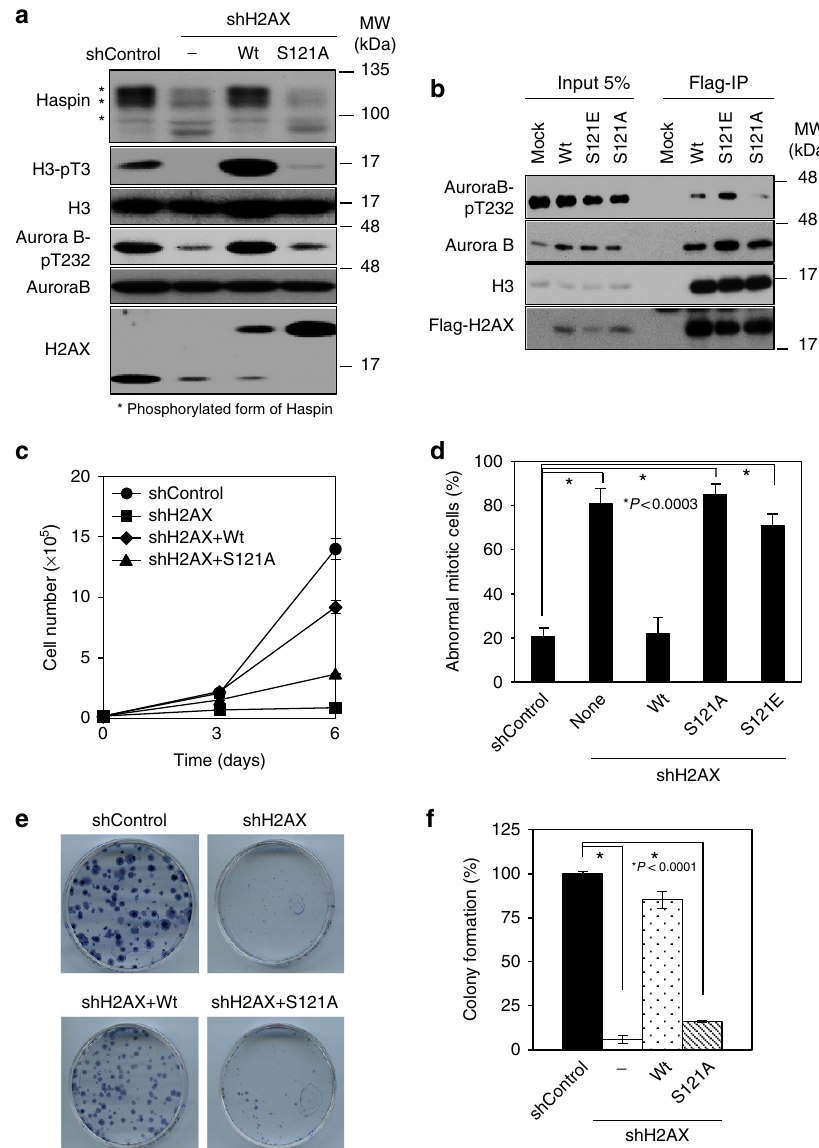
Figure 6 | H2AX-pS121 functions as a platform for the recruitment of activated Aurora B and is essential for cell proliferation. ( a ) HeLa cells expressing the Dox-inducible shControl, shH2AX with/without Flag-tagged wild-type (Wt) or S121A mutant H2AX were treated as in Fig. 2d. Chromatin fractions were subjected to immunoblotting using the indicated antibodies. ( b ) A Flag pull-down assay was performed using lysates from nocodazole-treated 293Tcells expressing Flag-H2AX WT, S121E or S121A. Bound proteins were subjected to immunoblotting using the indicated antibodies. ( c ) HeLa cells as in a were cultured in the presence of doxycycline (1 m gml (cid:2) 1 ) and their numbers were counted at the indicated times. Data are shown as means ± s.d. of at least three independent experiments. ( d ) HeLa cells with H2B-EGFP expressing the Dox-inducible shControl, shH2AX and Flag-H2AX-WT, H2AX-S121A or H2AX-S121E were subjected to time-lapse imaging and mitotic progression was observed. Quantification of cells showing abnormal mitosis is shown. Data are expressed as means ± s.d. of at least three independent experiments ( n Z 20, Student’s t -test). ( e , f ) A quantitative colony formation assay was performed using cells as in c and data are shown as means ± s.d. of at least three independent experiments (Student’s t checkpoint signalling 35 . It is not yet clear how the phosphorylation of Haspin by Aurora B contributes its function; however, it is possible that H2AX-pS121 and Haspin- H3-pT3 act redundantly in culminated and circumscribed activation of Aurora B at centromeres. Thus, it should be of great interest to examine the phenotypes in H2AX and Haspin double KO mice.